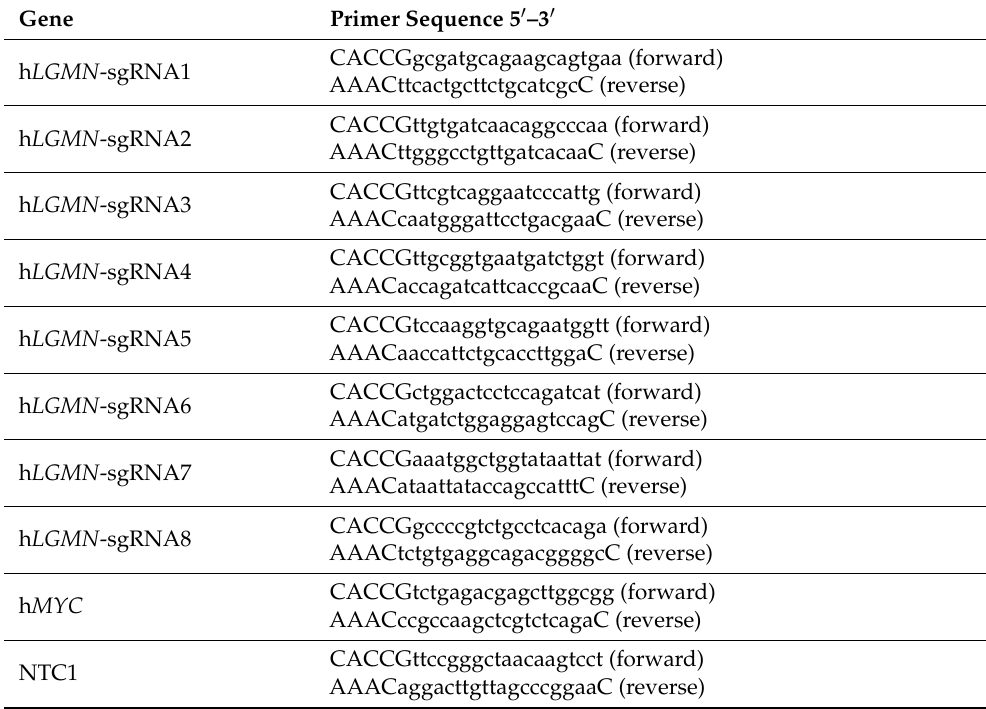
Table 2. Oligonucleotides for